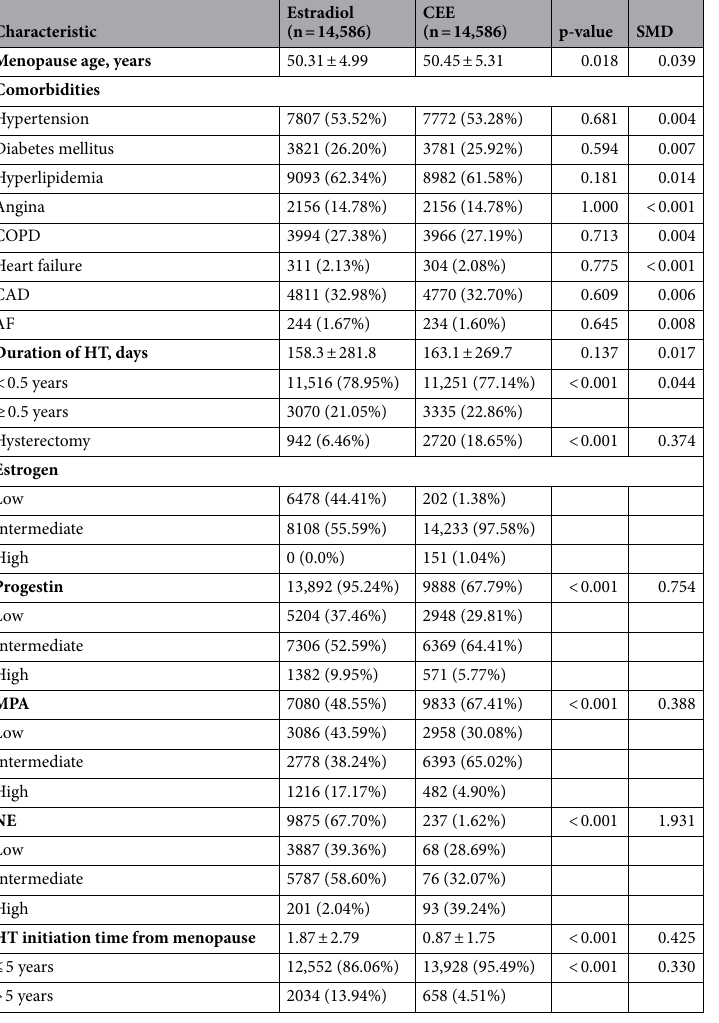
CEE, 2.5 mg/day of MPA, and 0.5 mg/day of NE; intermediate, 2 mg/day of E2, 0.625 mg/day of CEE, 5 mg/ day of MPA, and 1 mg/day of NE; high, 3 mg/day of E2, 1.25 mg/day of CEE, 10 mg/day of MPA, and 2 mg/ day of NE. CEE, conjugated equine estrogen; SMD, standardized mean difference; COPD, chronic obstructive pulmonary disease; CAD, coronary artery disease; AF, atrial fibrillation; HT, hormone therapy; MPA, medroxyprogesterone acetate; NE, norethindrone